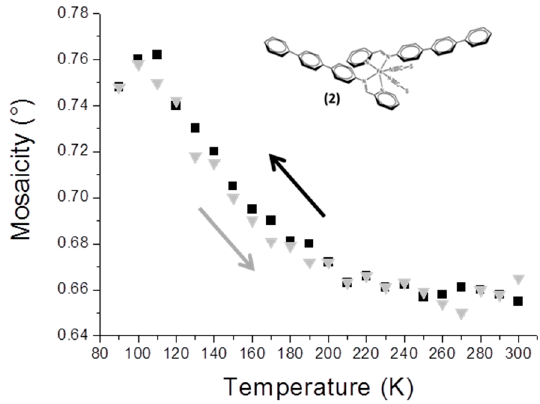
Figure 2. Temperature dependence of the mosaicity for a crystal of [Fe(PM-TeA) 2 (NCS) 2 ]·0.5MeOH in the cooling (black squares) and warming (grey triangles) modes.